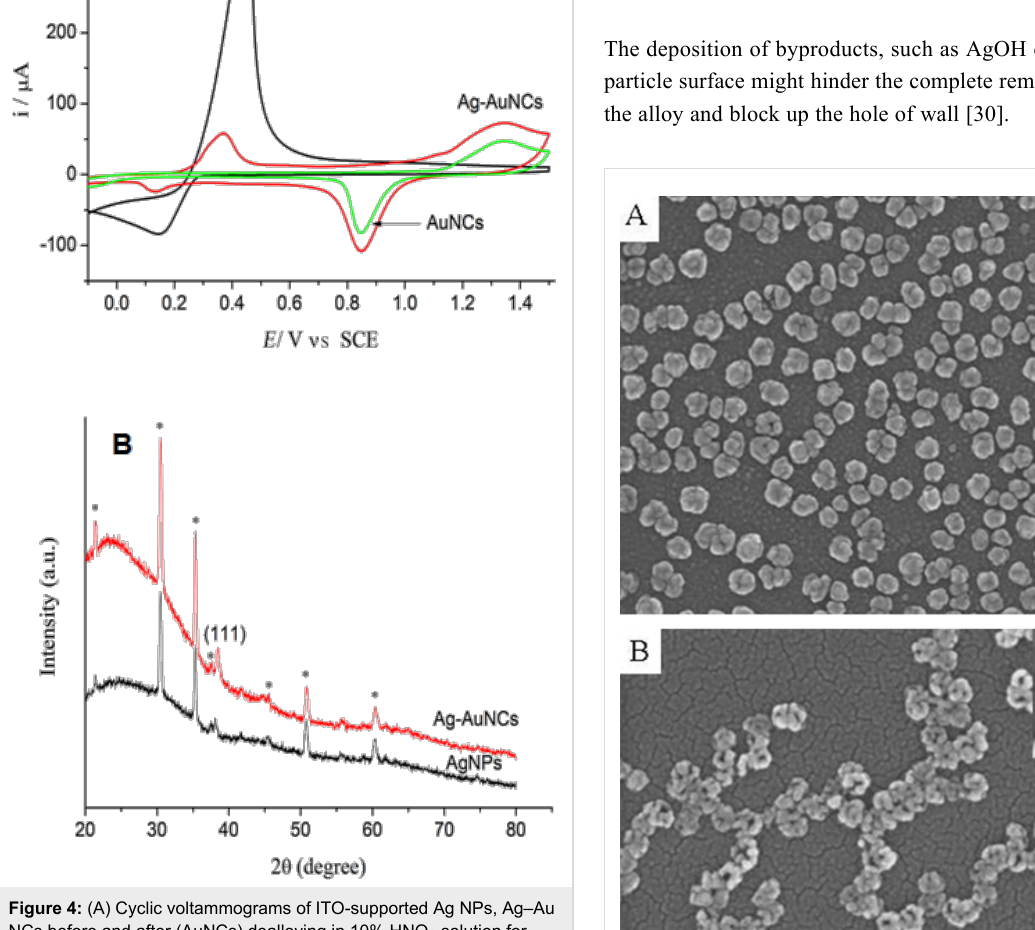
reflection was observed at 2 θ = 38.5°, corresponding to the (111) crystallographic plane. The similar peak position was expected after the replacement reaction because gold and silver have nearly the same lattice constant.